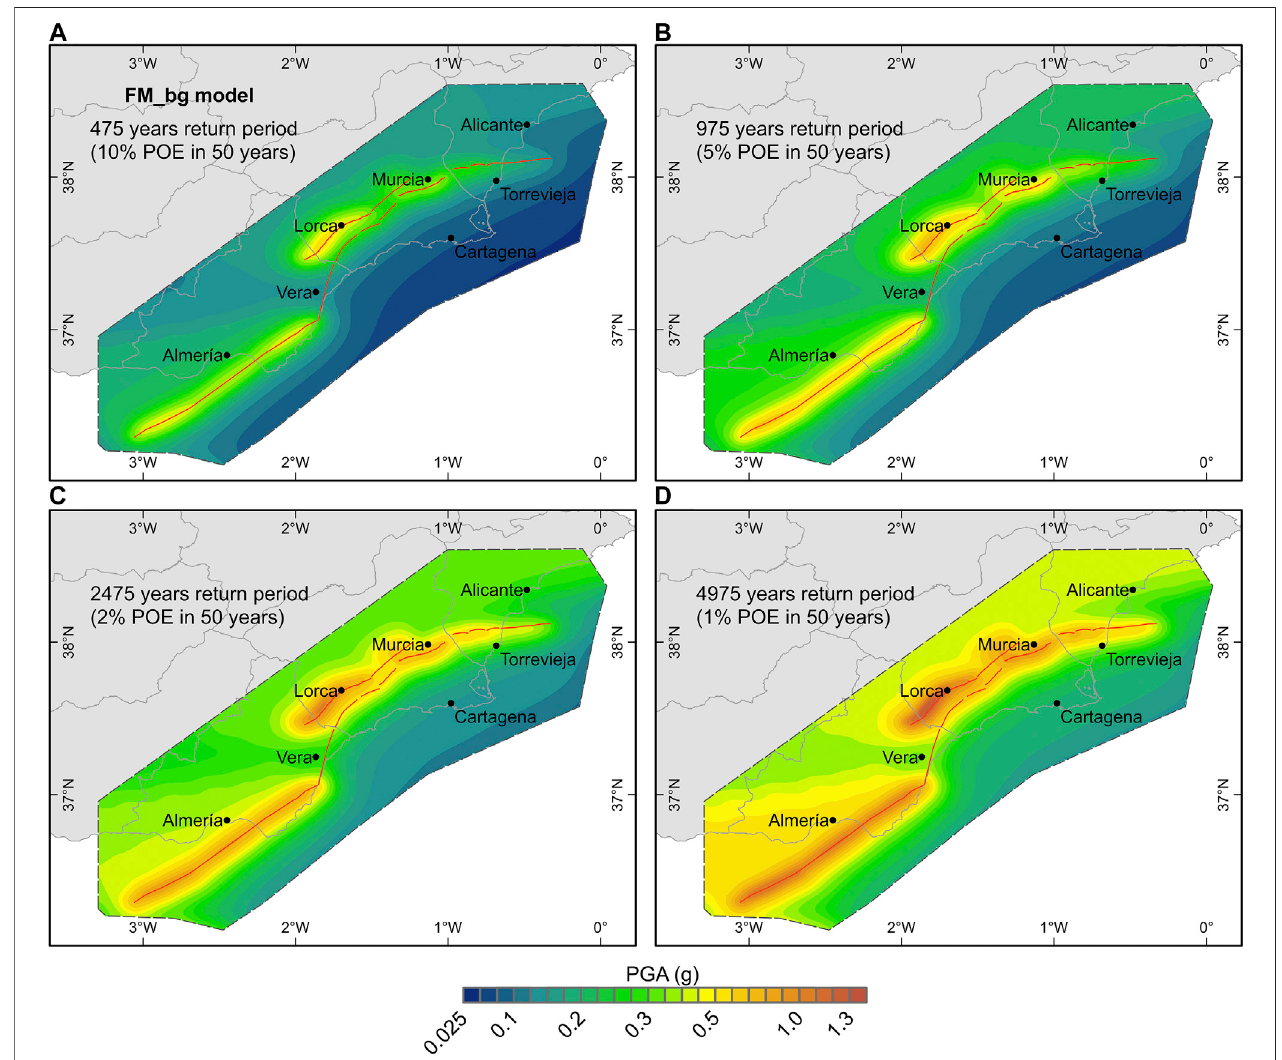
FIGURE5 |(A) Mean hazard maps for PGA(g) ofthe FM_bg model for the return periods (RPs) of475 years; (B) 975 years; (C) 2,475 years and; (D) 4,975 years, equivalenttotheprobabilitiesofexceedance(POE)of10%,5%,2%,and1%,respectively.Acommoncolorscaleissetforallreturnperiods.Themaincitiesintheregion and the traces of the EBSZ faults considered are depicted in red. See Figure 2A for the names of each fault.